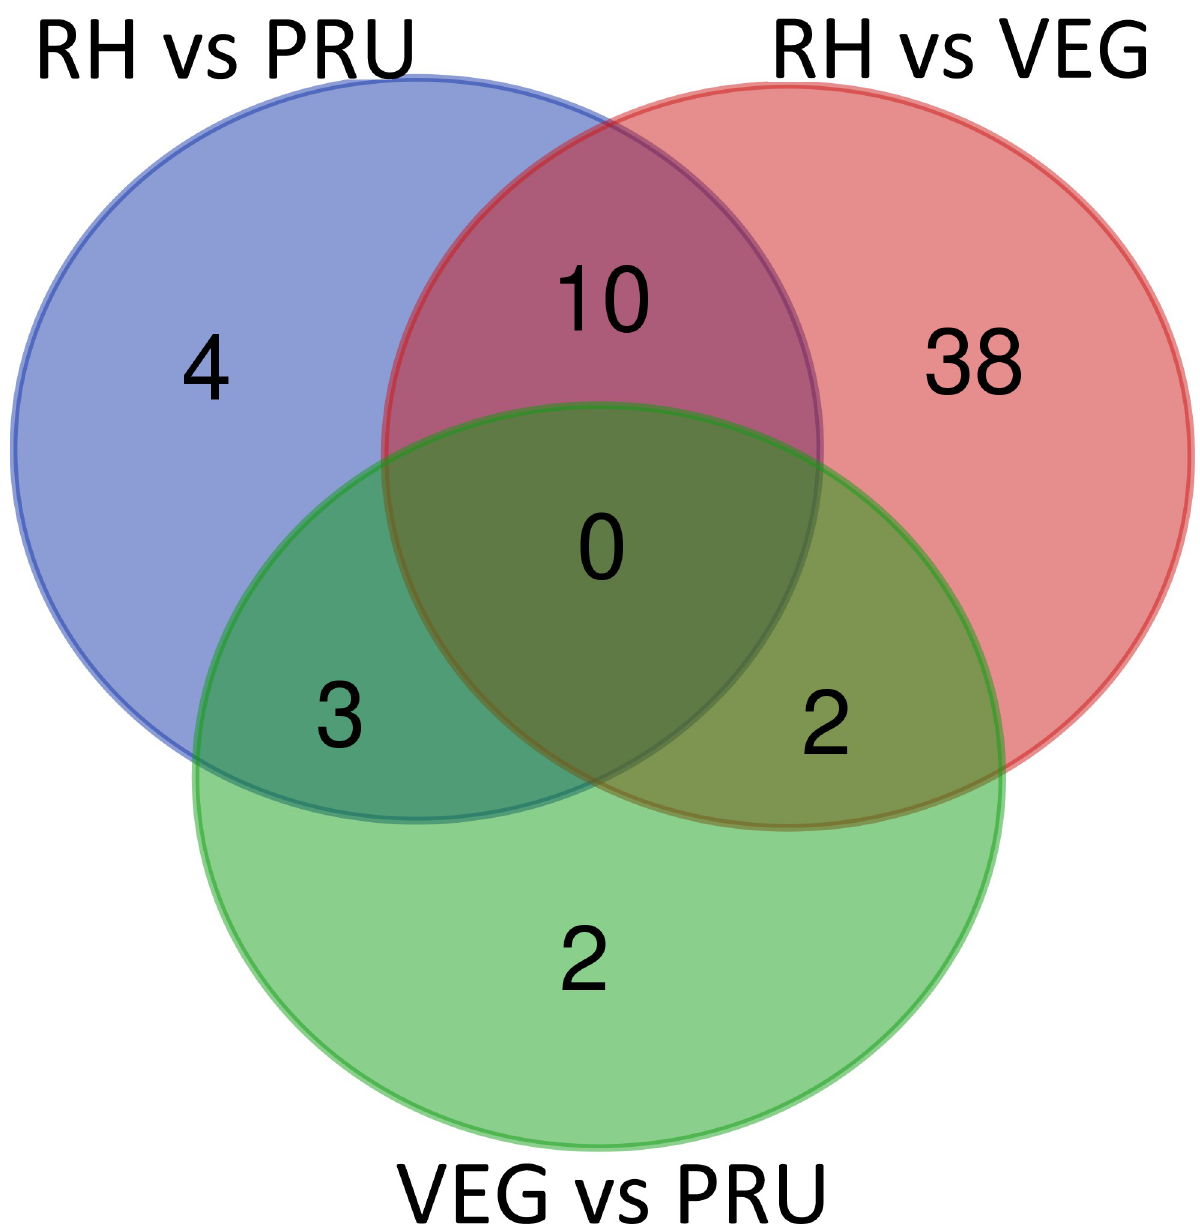
Fig 10. Venn diagram showing the unique and common differentially malonylated proteins in RH vs. PRU, RH vs. VEG and VEG vs. PRU.